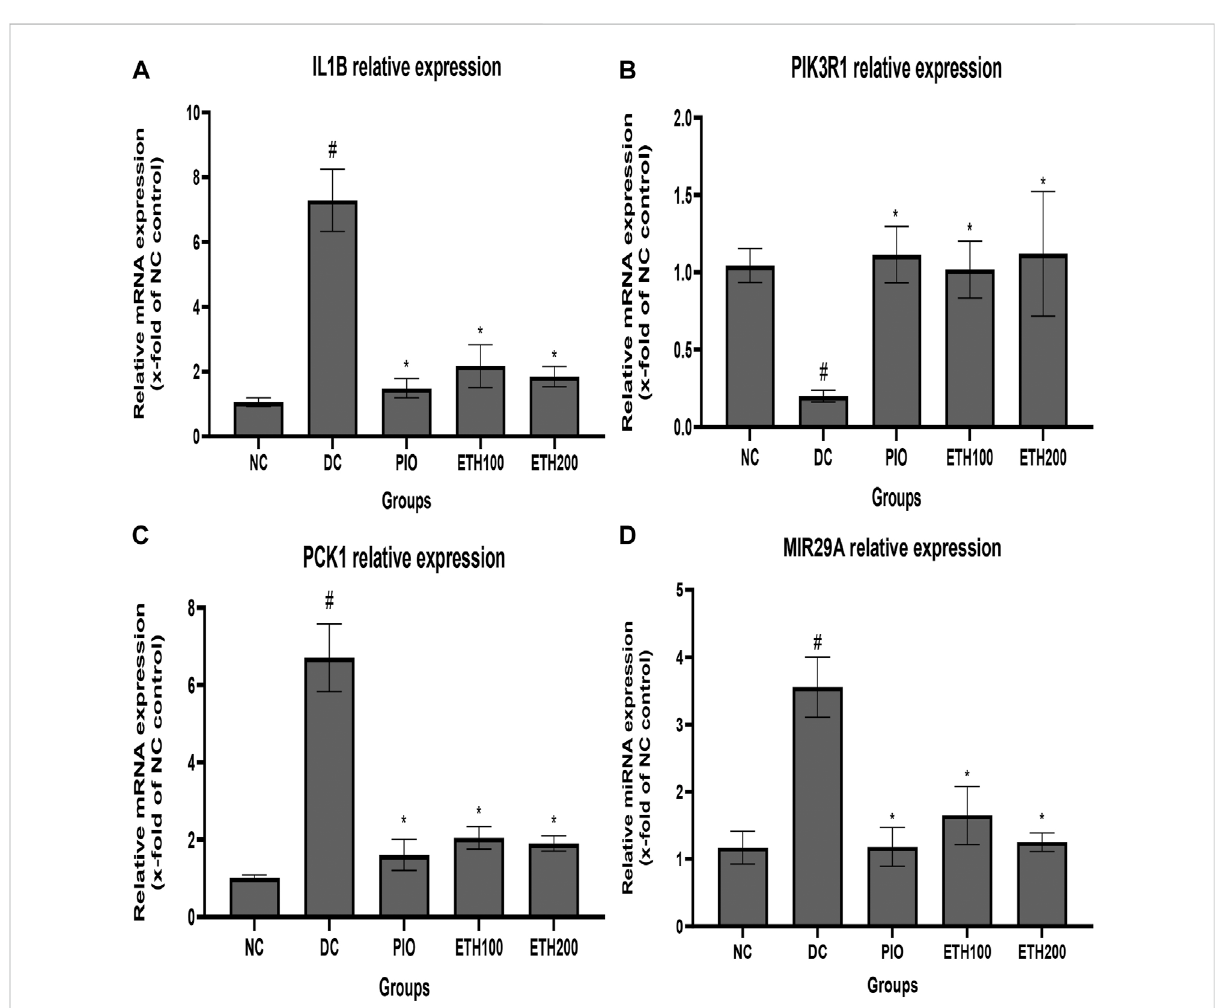
FIGURE 3 Effect of MA ethanolic extract on gene expression (A) MA ethanoic extract decreased the expression of the in fl ammatory cytokine IL1B (B) MA ethanoicextractincreasedtheexpressionofPIK3R1.MAethanolicextractdecreasedtheexpressionof (C) PCK1and (D) MIR-29a.Dataareexpressed as Mean ± SEM, n = 7, # p < 0.05 versus normal control, * p < 0.05 versus diabetic control. Adjusting the size of the images and resolution, adding the panels ’ letters, and combining the images was carried out using